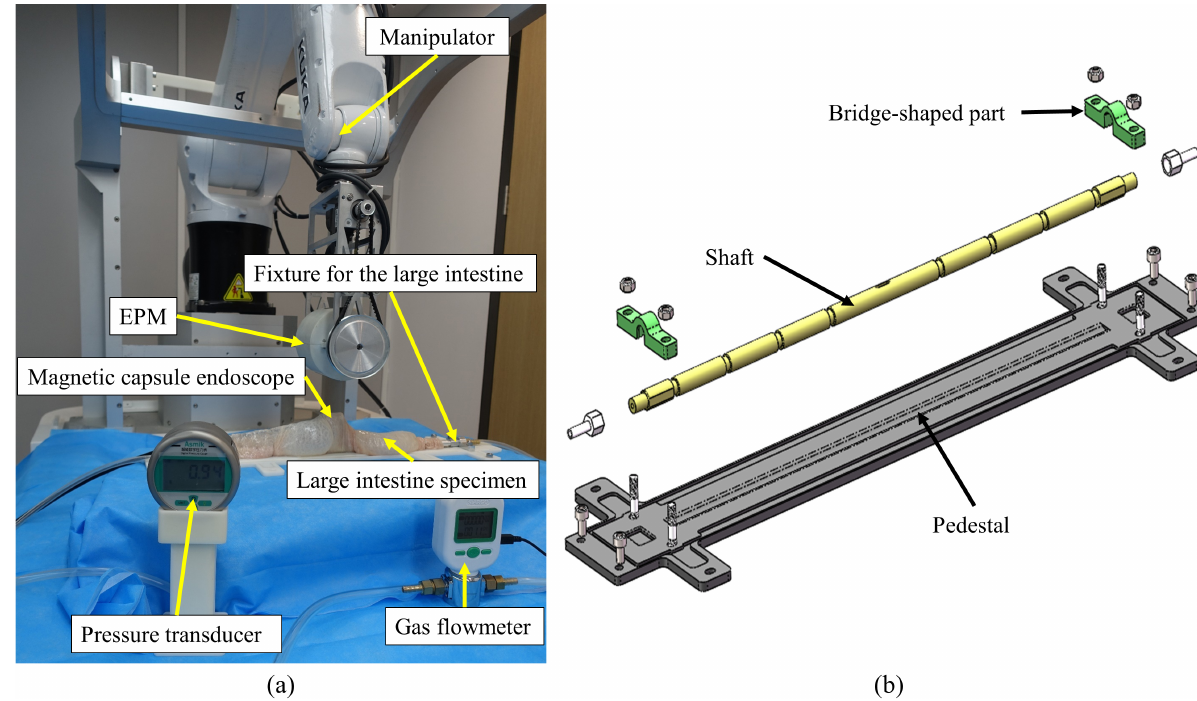
Figure 12. The platform used to evaluate the proposed motion recognition method of the magnetic capsule endoscope. ( a ): Experiment platform. ( b ): The fixture designed for mounting the large